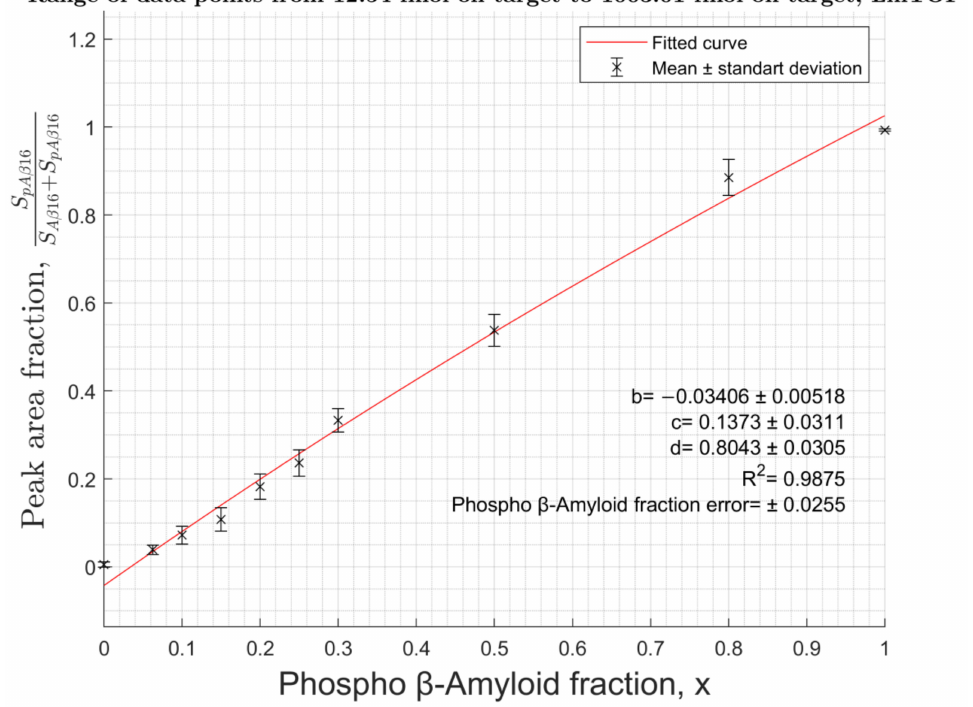
Figure 3. Calibration curve for A β 16 in linear mode on an AnchorChip target with 10 mg/mL DHB, 0.1% TFA.